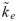
Comparing experimental methodologies to estimate ribosome elongation rates.Elongation rate estimate experiments were simulated for 2,647 human genes, using (A) Fluorescence Correlation Spectroscopy (FCS), (B) Run-Off Assays (ROA), and (C) Fluorescence Recovery After Photobleaching (FRAP). Top panels show the distributions of estimated k˜e for long genes (> 1000 codons, n = 658, purple), medium length genes (500 − 1000 codons, n = 1719, blue), and short genes (< 500 codons, n = 270, orange) using 100 mRNA spots for 300 frames at 1/3 FPS. The true elongation rate is denoted by a vertical dashed line. Bottom panels show the RMSE in elongation rate estimation as a function of the number of mRNA spots and the sampling rate. Red boxes highlight all experimental designs that yield a RMSE < 2.0. Asterisks represent the frame rate and number of repetitions used in panel (A). The ‘true’ elongation rate was set at k¯e=10, and the initiation rate was fixed at ki = 0.03 sec−1 for all simulations.